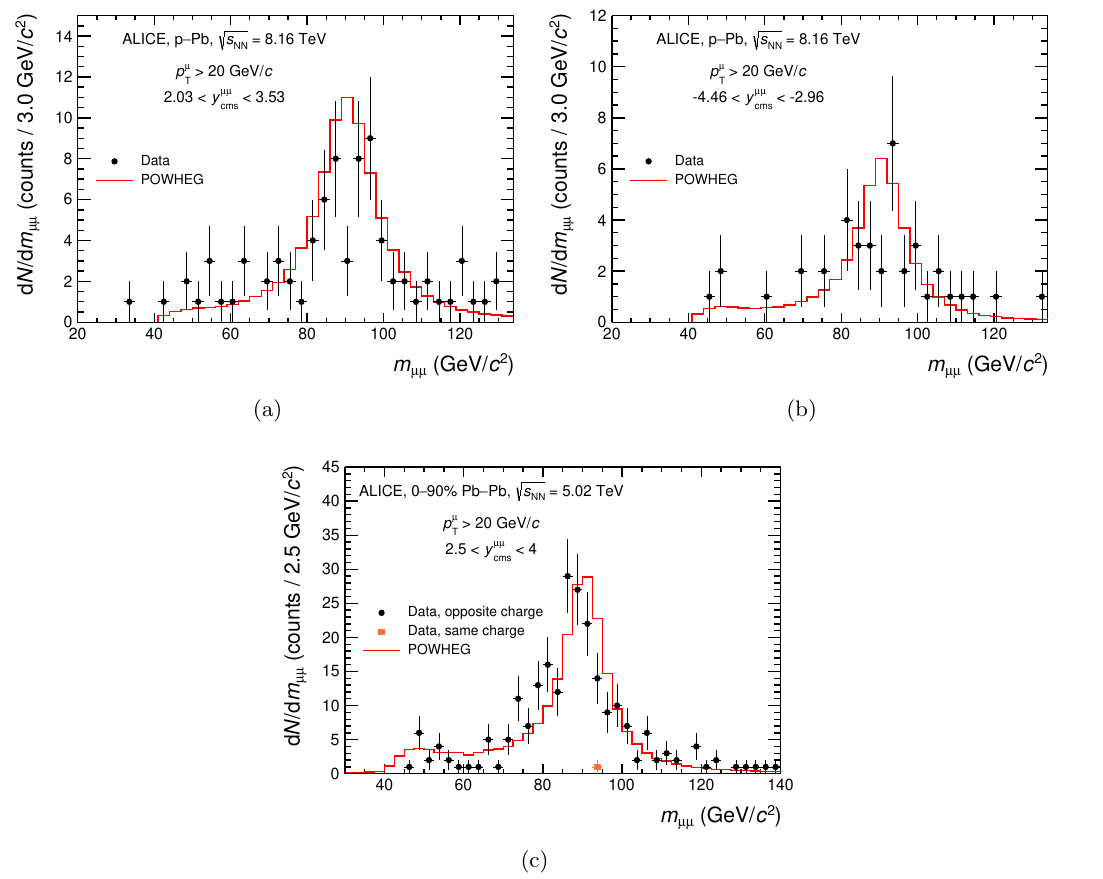
p s NN = 8 : 16 TeV in p s NN = 5 : 02 TeV. The > 20 GeV/ c (black points) T